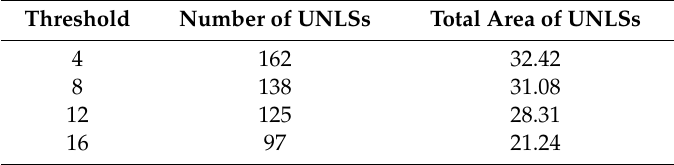
Table 6. Impact of the basic contour threshold value on the detection of UNLSs.